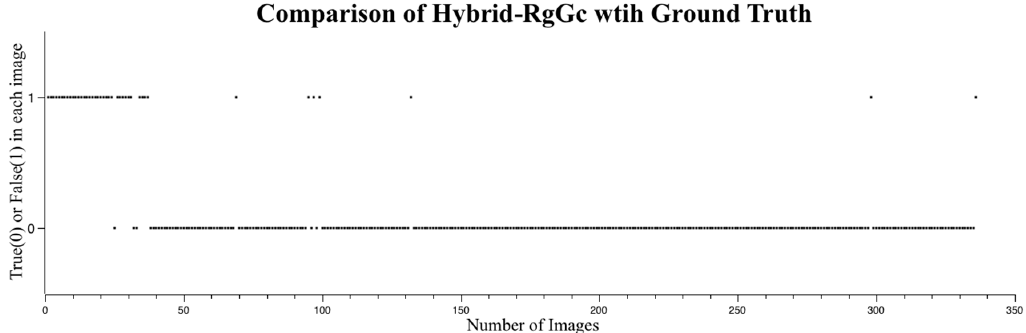
Figure 14. Hybrid RgGc accuracy. The accuracy was determined according to the ground truth. Each horizontal bar shows the accuracy with a different growing method. Outperforming both RegGro and GrowCut, the hybrid RgGc was 87.7% accurate.